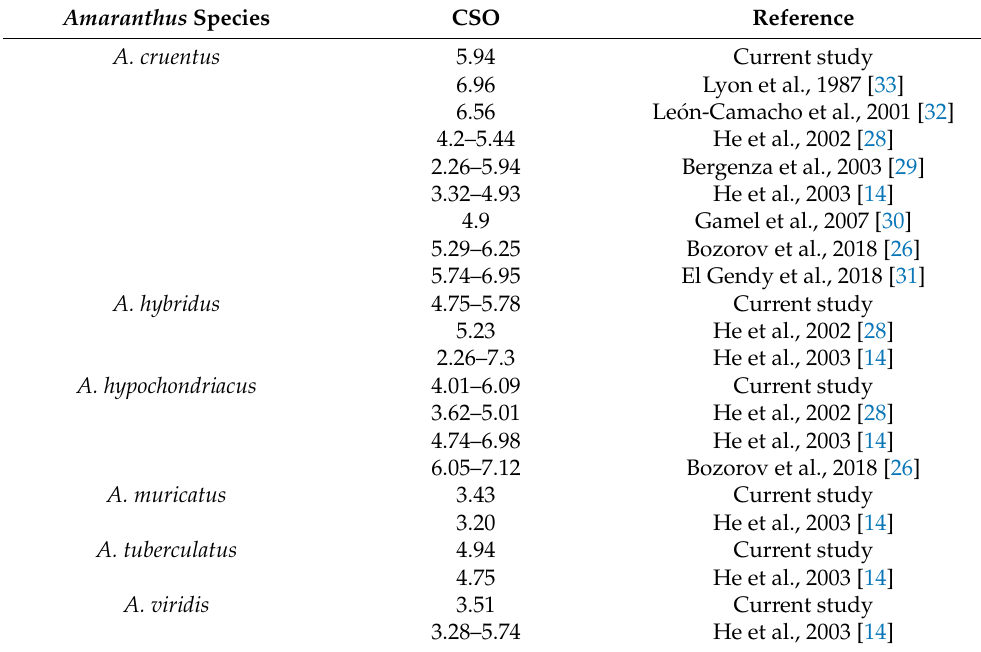
Table 3. Comparison between squalene content in oil CSO from this study and from the major references